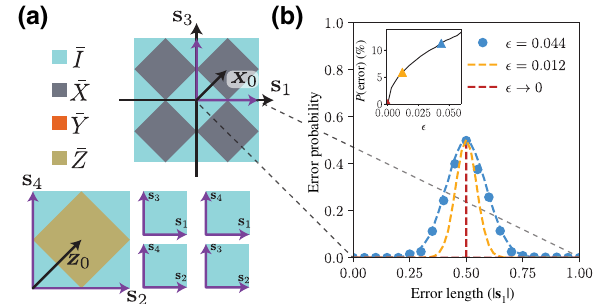
FIG. 8. Effect of translation errors in the tesseract code. (a) Logical operation applied (colors) as a function of the initial translation error in the planes given by span( s j , s k ). (b) Logical error probability as a function of the length of a translation error along s 1 . We compare the full quantum model (blue dots) and the classical model (dashed line). Inset: integrated logical error prob- ability given that an error η s 1 occurred, with η sampled uniformly in the interval [0,